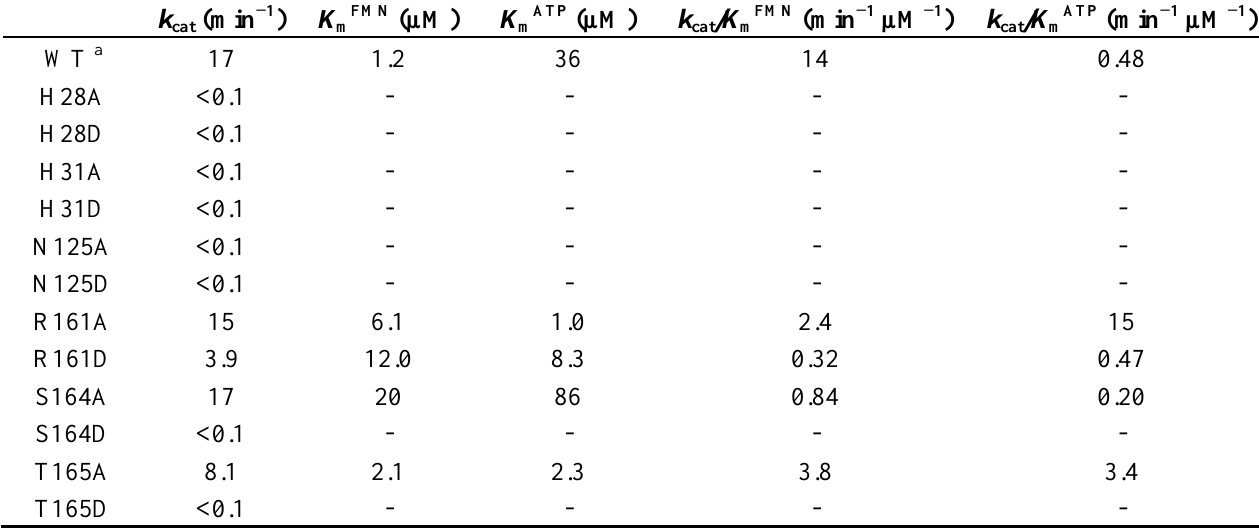
Table 1. Steady-state kinetic parameters for the ATP:FMN adenylyltransferase (FMNAT) activity (FMN + ATP → FAD + PPi) of the different Ca FADS forms. Data obtained at